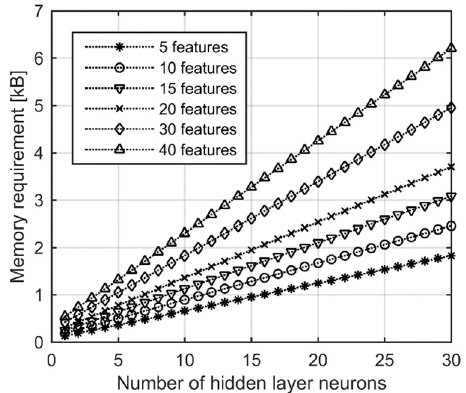
Figure 4. Memory requirements for the implementation of MLP networks.